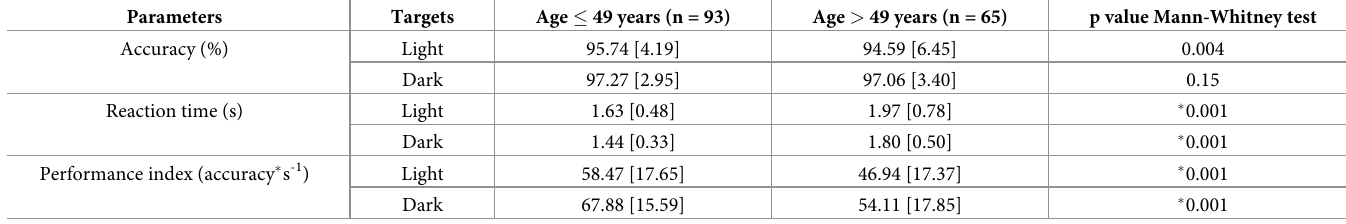
Table 1. Summary (median [IQR]) of the outcome variables between the two groups.